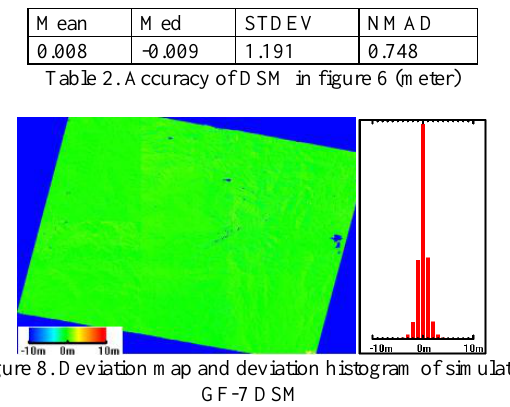
Figure 8. Deviation map and deviation histogram of